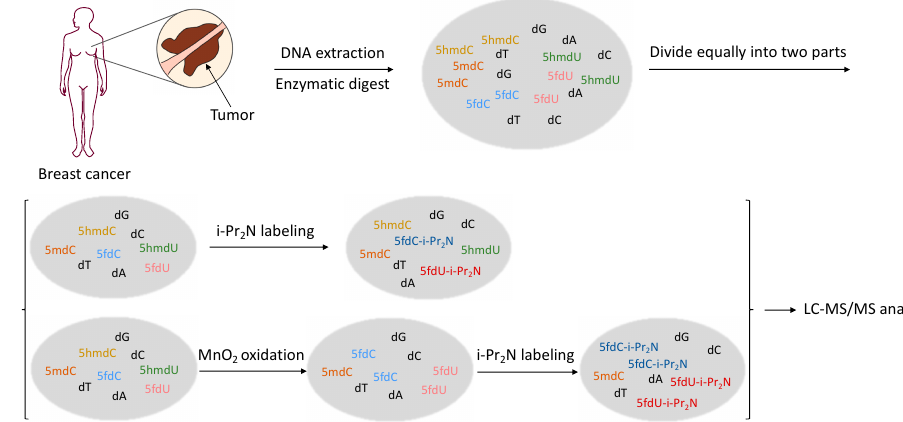
Figure 3. Scheme of practical sample analysis.